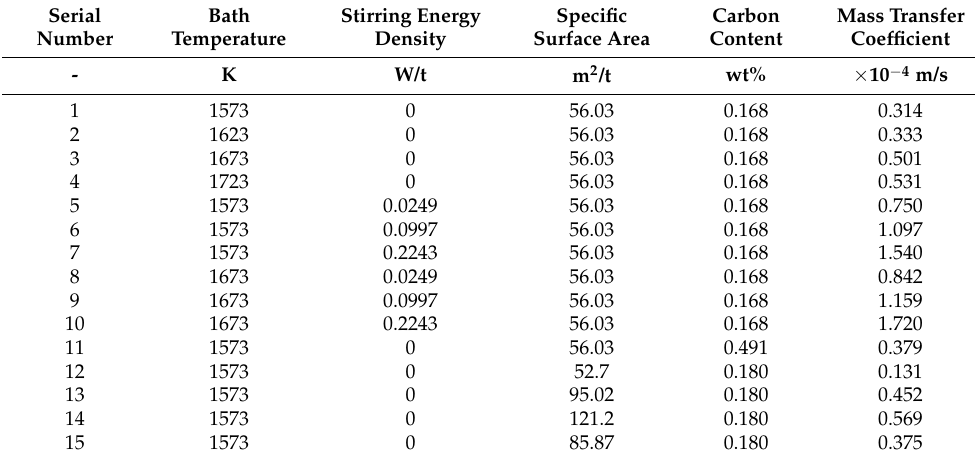
Table 2. Raw data of the evaluation model.